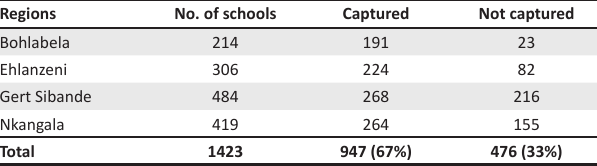
TABLE 2: Background of the Annual National Assessment conducted in Mpumalanga Province.